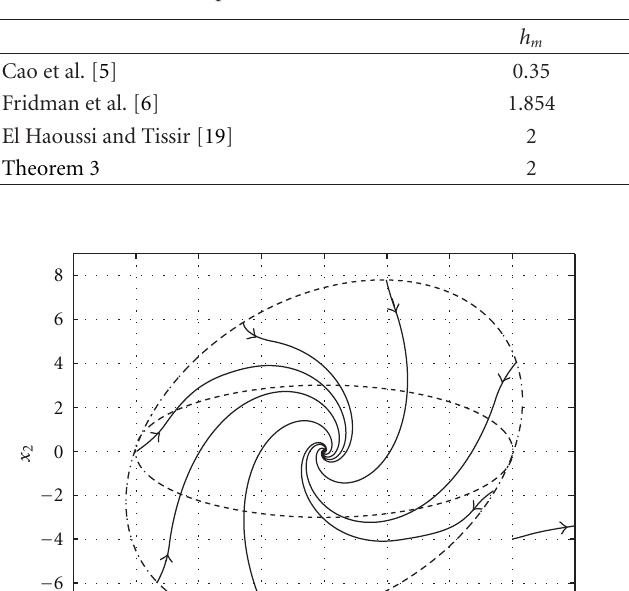
Table 1: Comparison of bounds on h m , maximum radius δ , and stabilizing control gains K using di ff erent approaches.